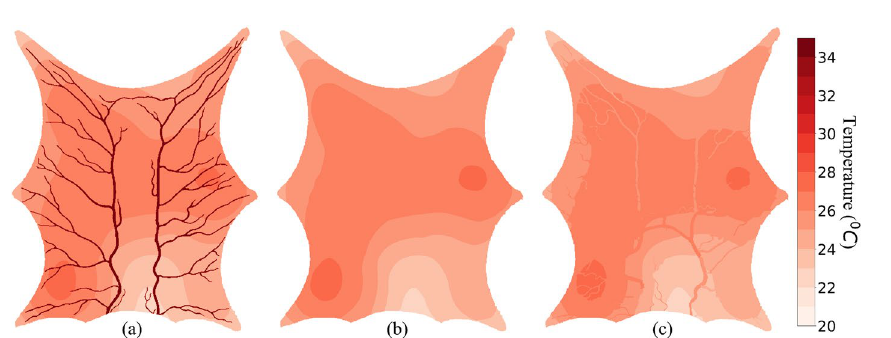
2 ◦ C and ǫ = 10mm ( a ) Layer 1, ( b ) Layer 2,